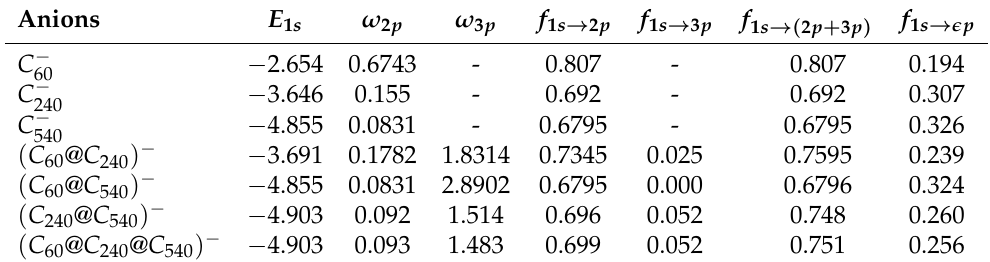
Table 1. Calculated E 1 s ground-state energies, ω 2 p and ω 3 p energies of the 1 s → 2 p &3 p